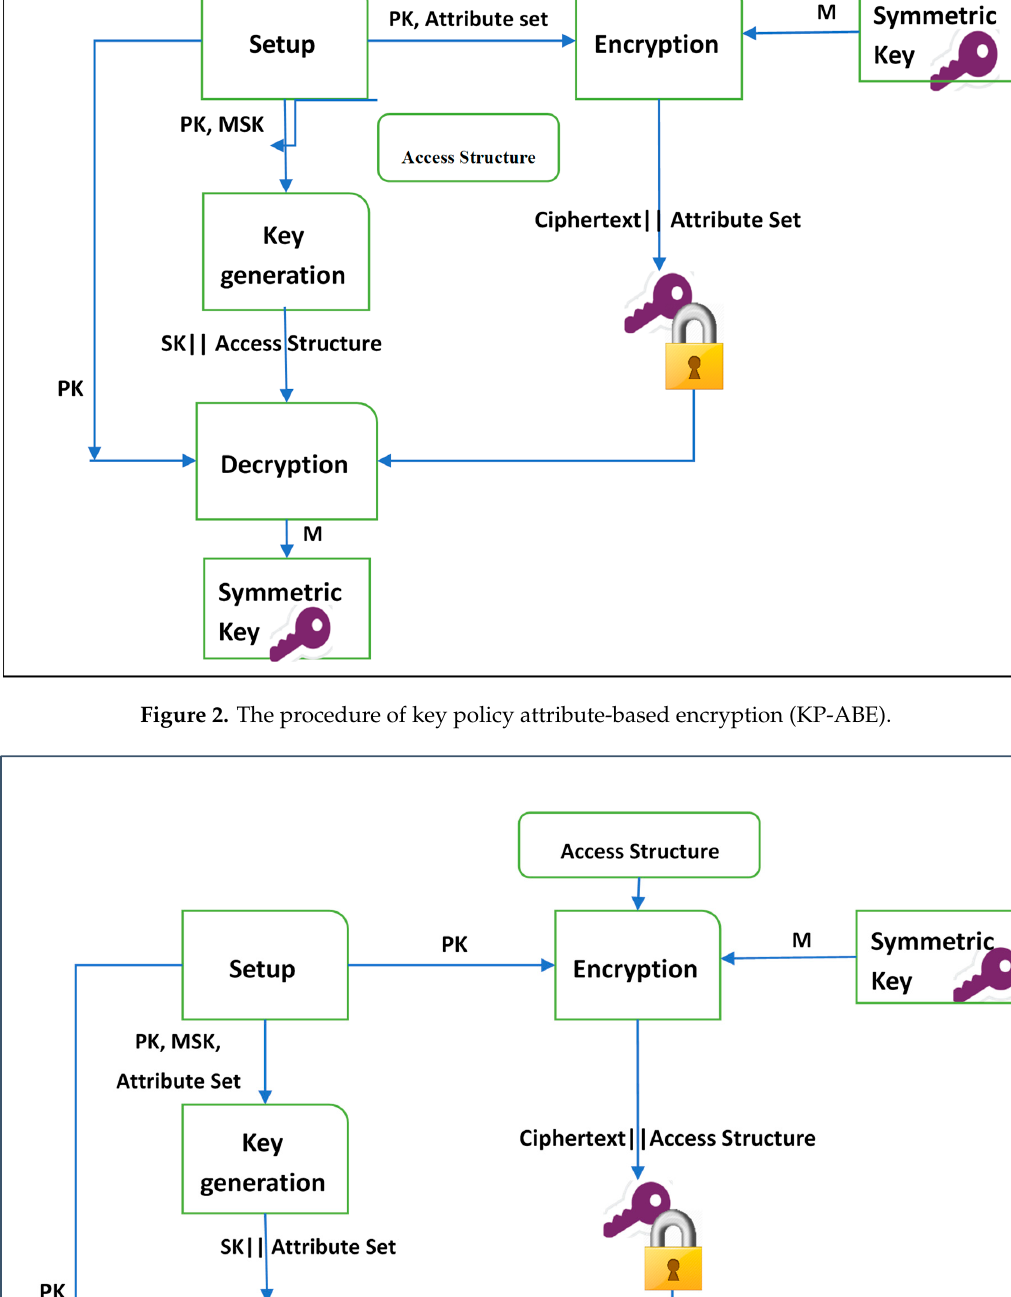
Figure 3. The CP ‐ ABE mechanism. Figure 3. The CP-ABE